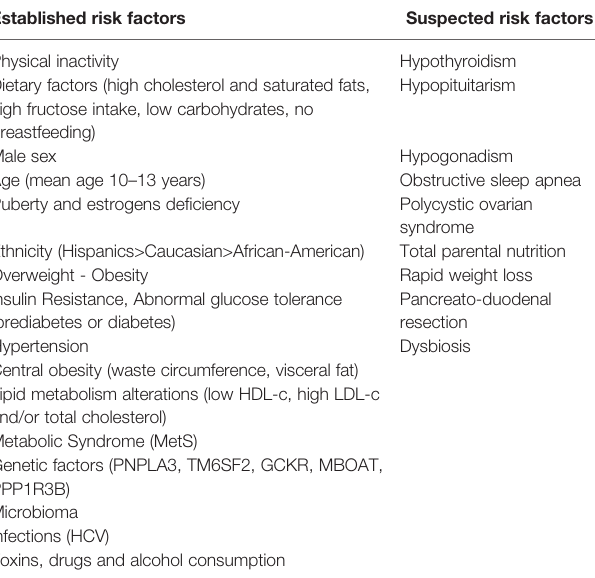
TABLE 1 | Risk factors for NAFLD in children and